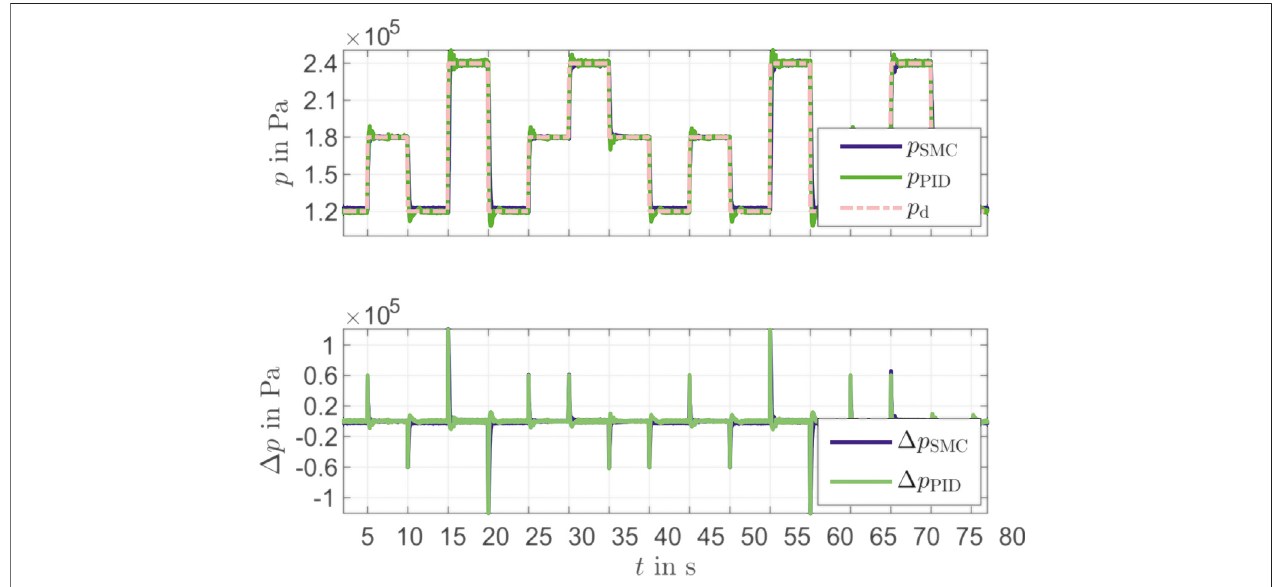
FIGURE 5 | Comparison between SMC and PID Controller for pressure